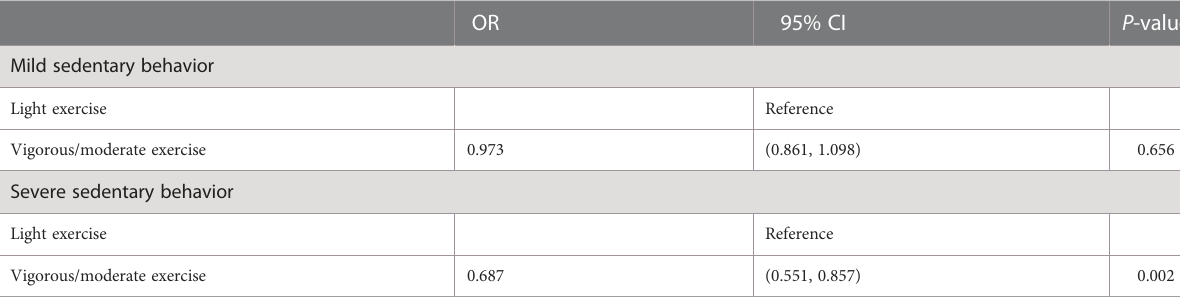
TABLE 3 The associations between exercise and sleep disturbance by sedentary behavior.